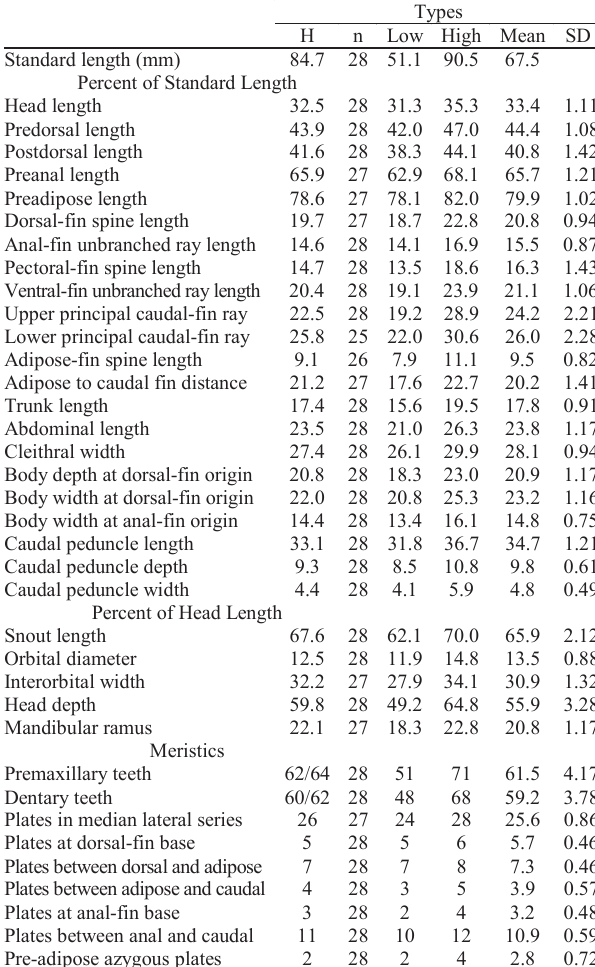
Table 1. Morphometric and meristic data of Pareiorhaphis scutula . Values are given as percent of standard length or head length. SD = standard deviation, n = number of specimens, H = holotype.